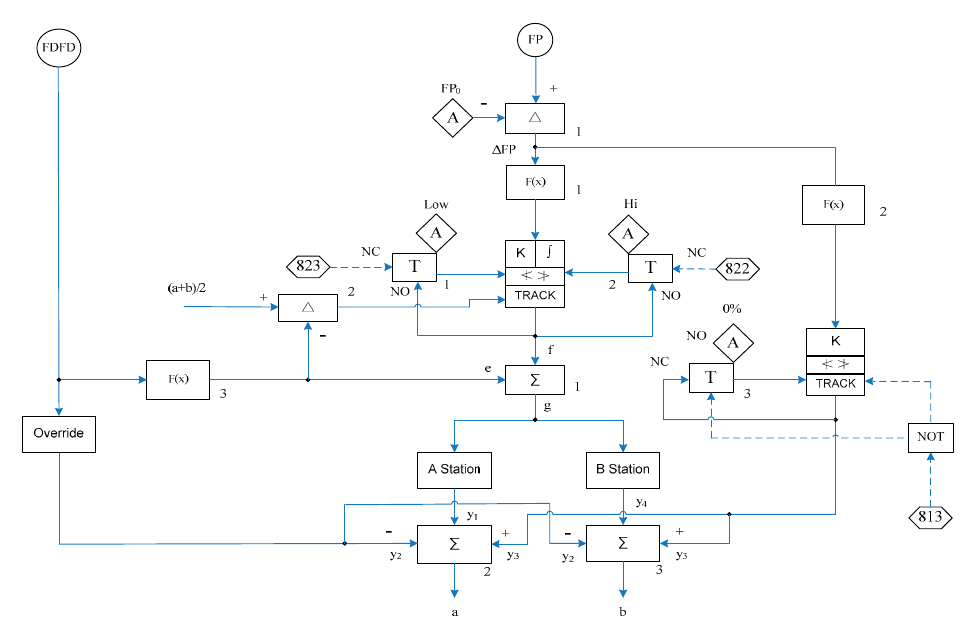
Figure 33. The SAMA diagram of the furnace pressure control system.